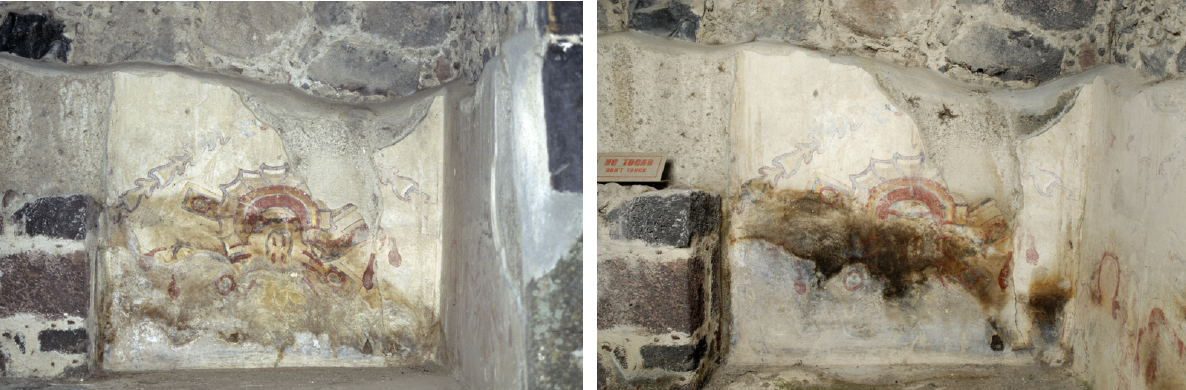
Figure 1: Teotihuacan mural, same painting taken with a gap of 4 years. (Photographic Archive of the “Pre-Hispanic Mural Painting in Mexico”